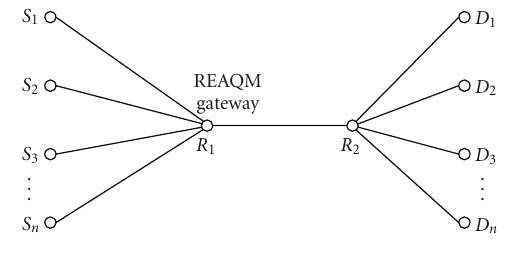
Figure 1: Network topology.